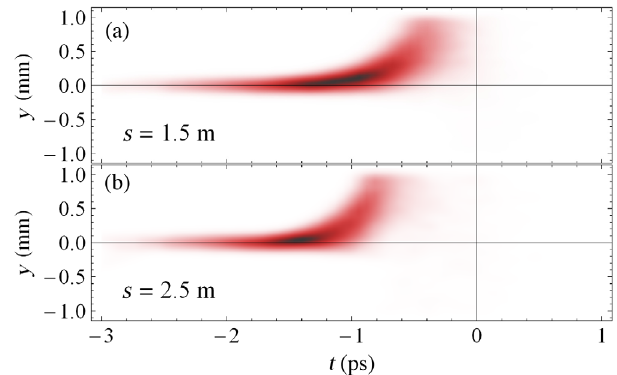
FIG. 12. Transverse-longitudinal distribution of particles after propagation distances of s ¼ 1 . 5 and 2.5 m from the beginning of the structure ( s ¼ 0 ). The beam is on the structure axis. F x is included.